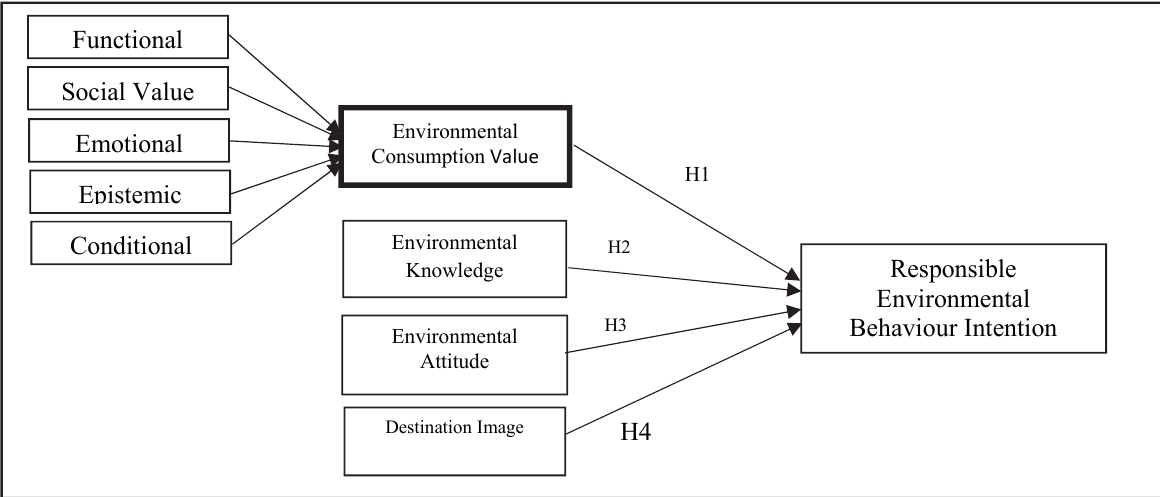
Fig. 1 . Conceptual